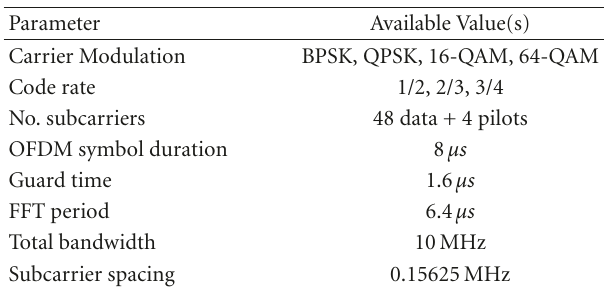
Figure 6: One path’s linear interpolator. Table 5: Main features of the implemented IEEE 802.11p